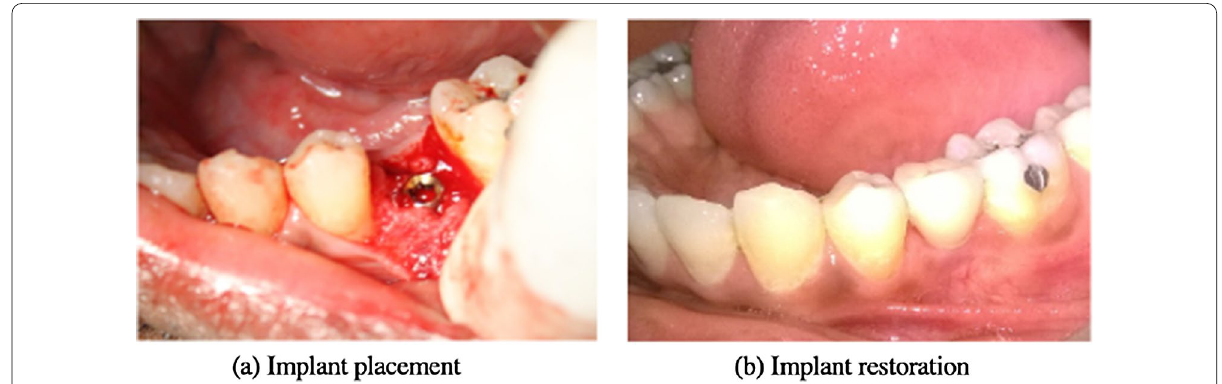
Fig. 3 Surgical placement and restoration of implant. a Implant placement, b Implant